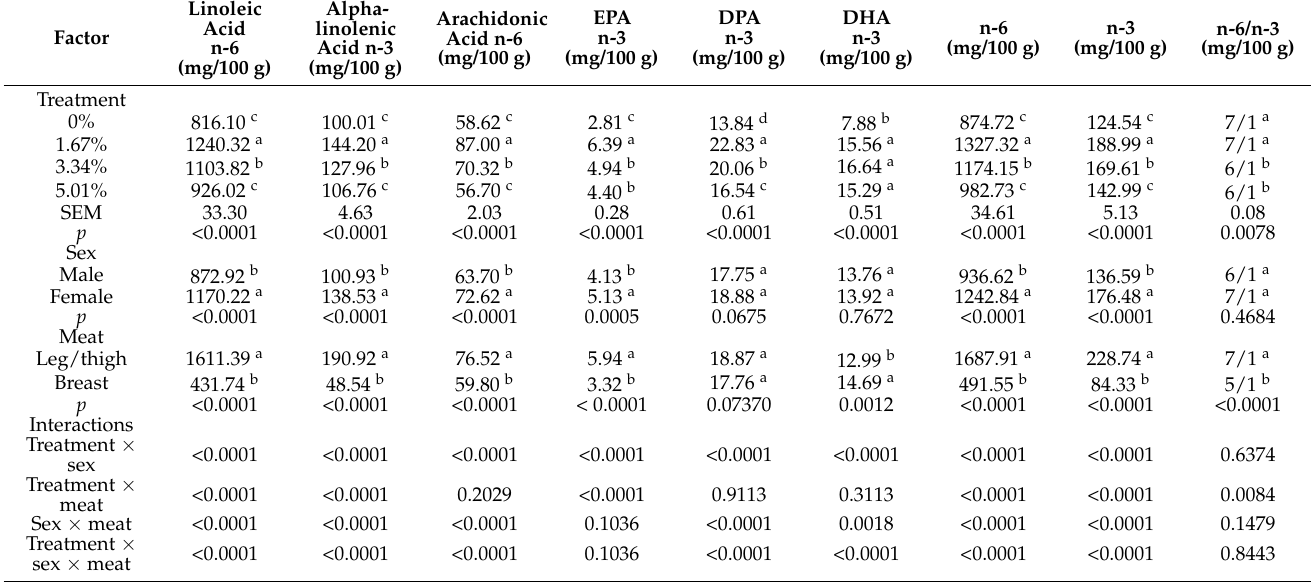
Table 4. Effect of treatment, sex, and leg/thigh breast on the content of n-3 and n-6 fatty acids when incorporating giant squid ( Dosidicus gigas ) meal into the diet of the